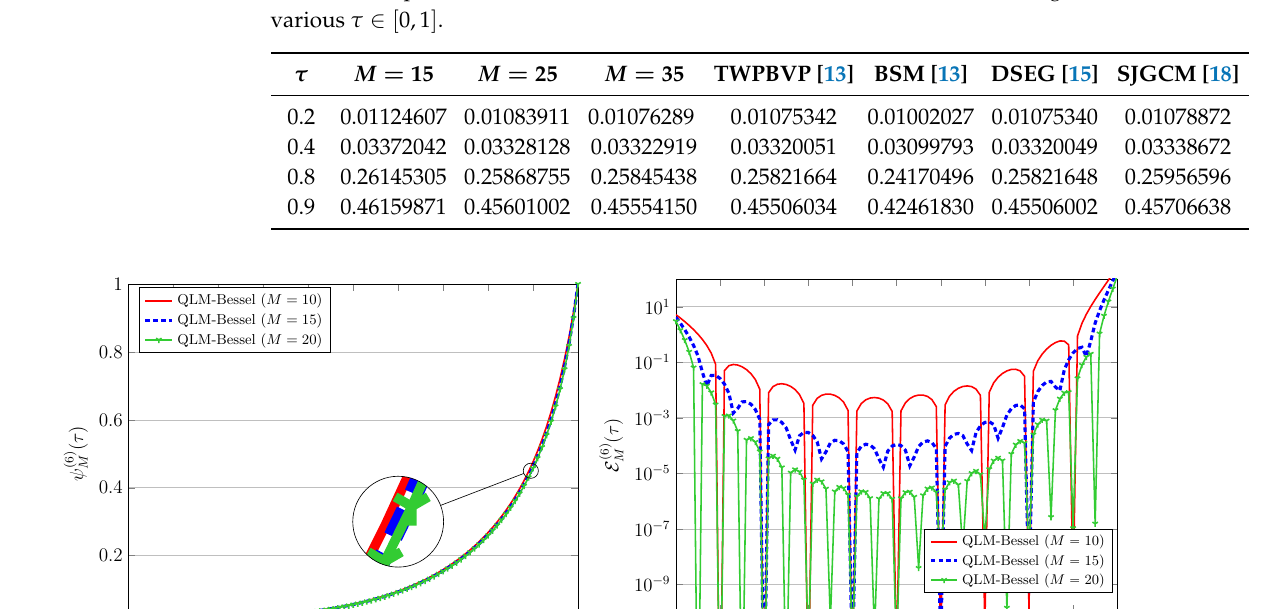
Table 4. Comparison of numerical solutions in QLM-Bessel for Test case 3 using M = 15,25, 35 and [ 0,1 ] . various τ ∈